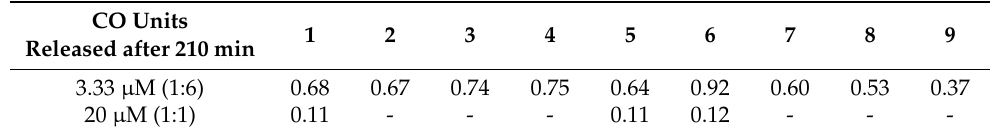
Table 2. CO units released by compounds 1 – 9 after 210 min of incubation working at 1:6 CORM-Mb ratio and by compounds 1 , 5 and 6 at 1:1 CORM-Mb